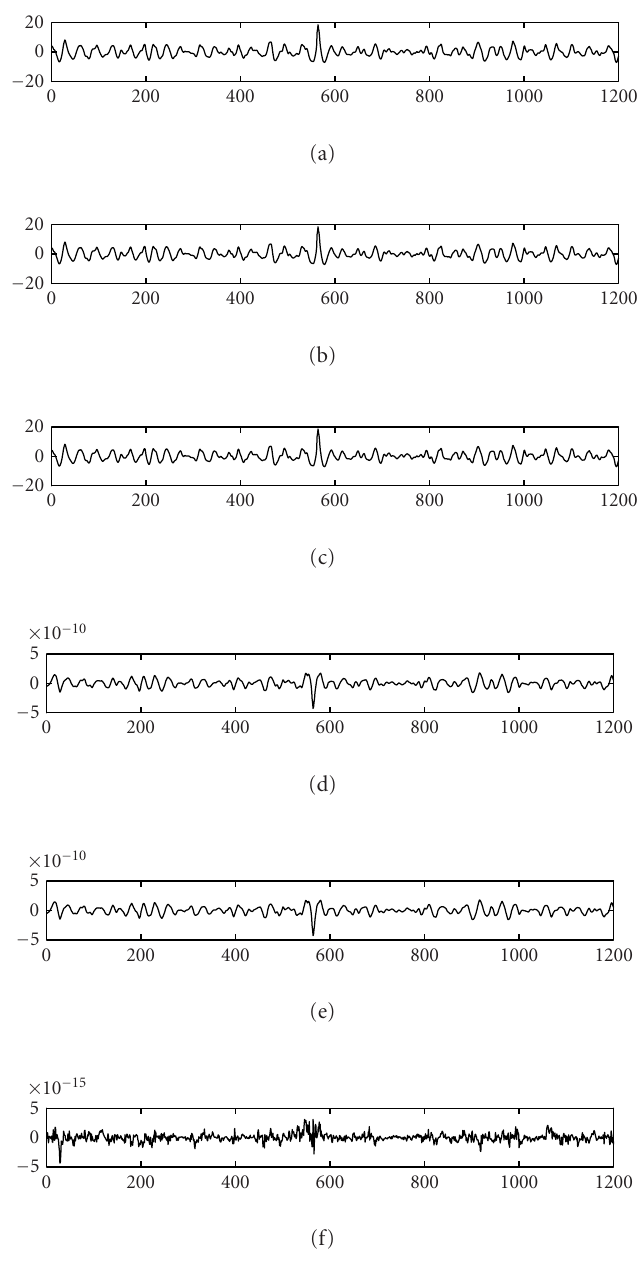
Figure 3.3. Reconstruction and approximation at level 5. (a) Original signal X . (b) A 0 : reconstructed from the multilevel wavelet decomposition. (c) Sum of approximation and details: A 5 + D 5 + D 4 + D 3 + D 2 + D 1 . (d) X − A 0 . (e) X -Sum. (f) A 0